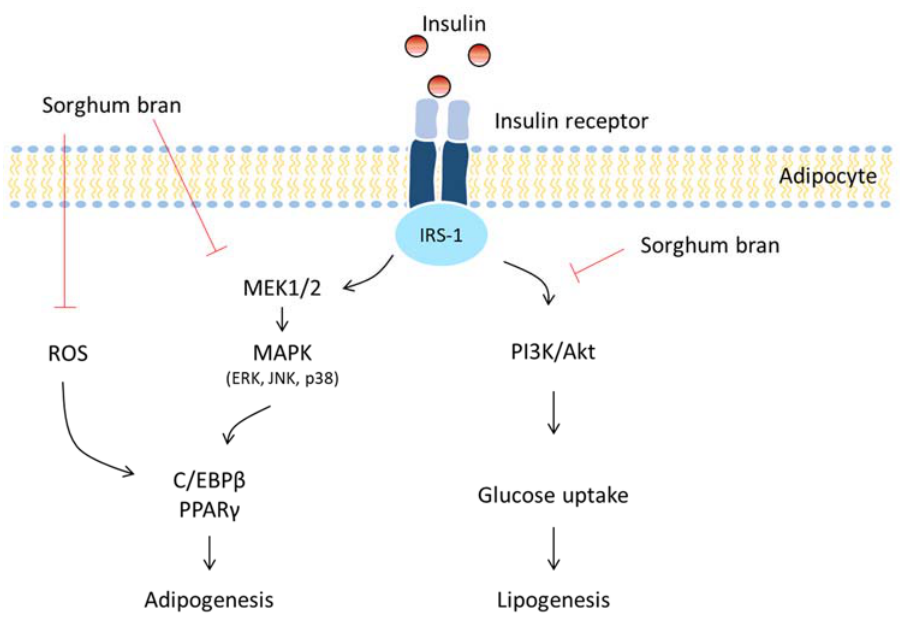
Figure 8. The schematic diagram proposing anti-adipogenic and anti-lipogenic mechanisms of sor ‐ ghum bran extracts in differentiated 3T3 ‐ L1 cells.